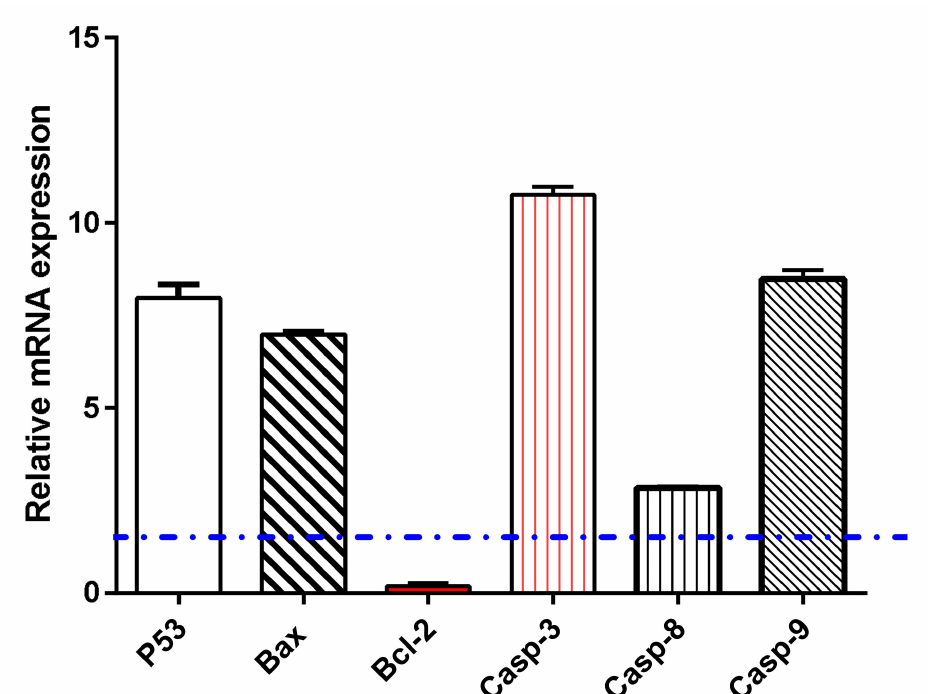
Figure 5. Evaluation of flower extract AgNPs on A549 cell gene expression in both control and treated samples (IC 50 = 1.52 µ M, 48 h). β -actin was used as a house-keeping gene. Dashed line represents for the fold change of untreated control. Fold of change is calculated by 2ˆ - ∆∆ CT , where ∆∆ CT is the difference between mean values of genes CT values in the treated and control groups.